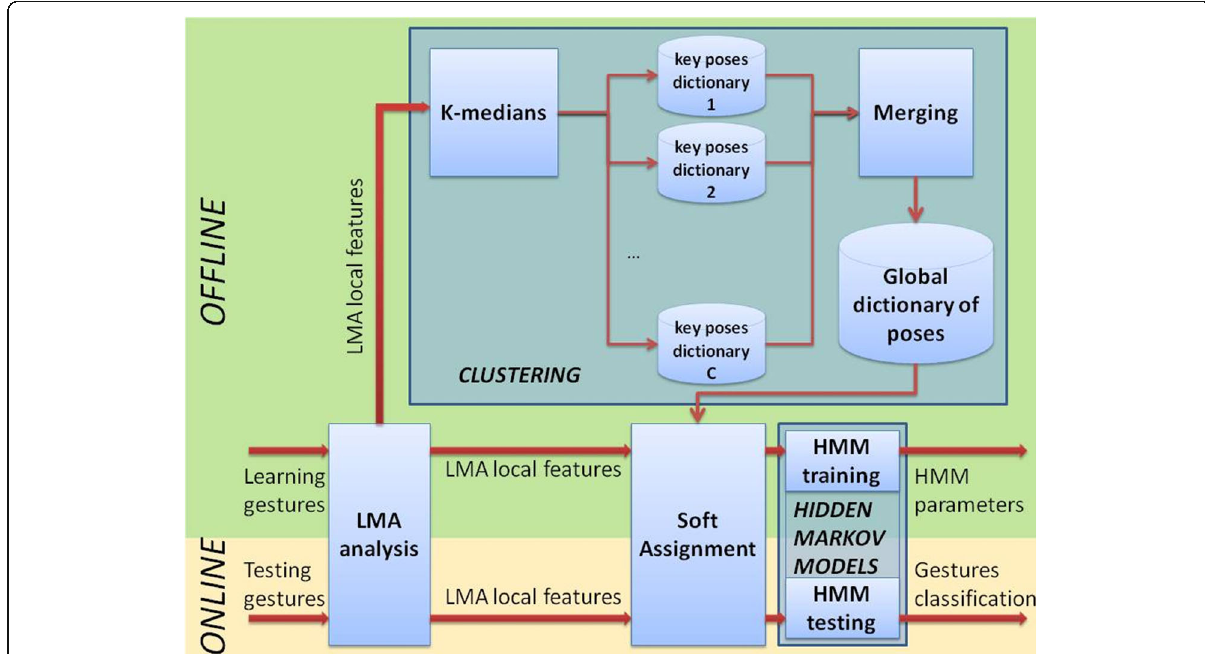
Fig. 2 Overview of the dynamic gesture analysis approach